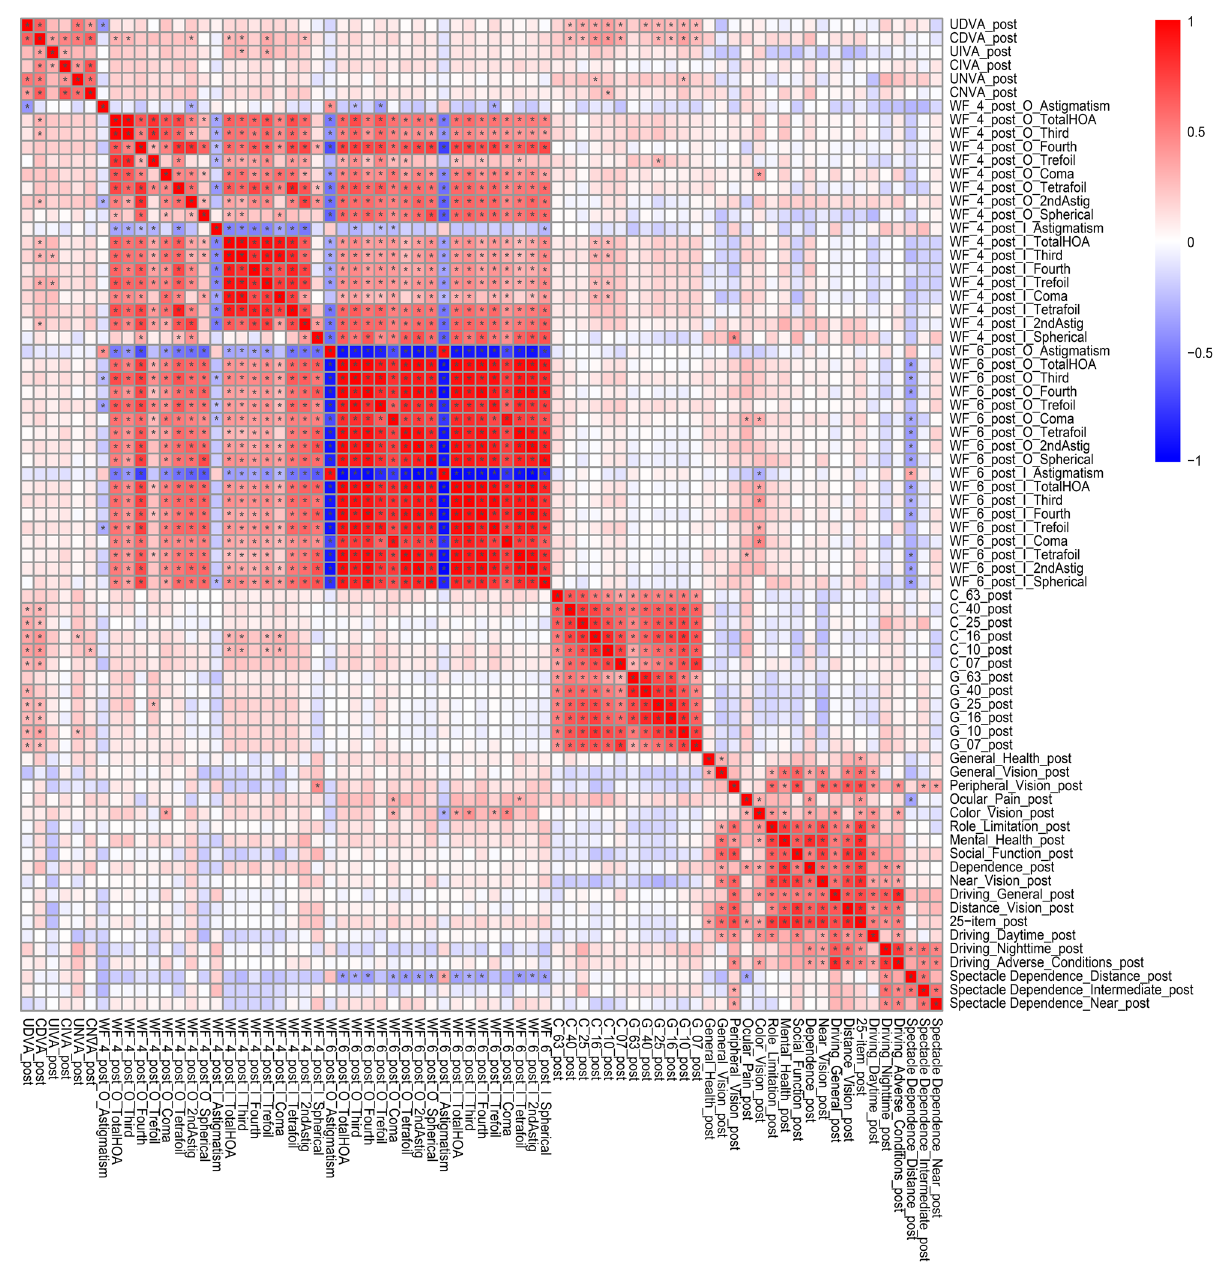
Figure 4. Heatmap of Pearson’s correlation coefficients between all possible combinations of variables, which were adjusted by multiple regression with the explanatory variables in Table 1, in the diffractive bifocal (TECNIS ZMB00) IOL group. The asterisk * in this figure indicates a significant correlation between two parameters at p < 0.00002 after Bonferroni’s correction. The two-sided t test was applied to evaluate the significance of differences between the two groups. The sample size for each parameter is shown in Supplementary Table S3(C). The illustration was performed using a commercially available software program (R, version 3.6.1; R Core